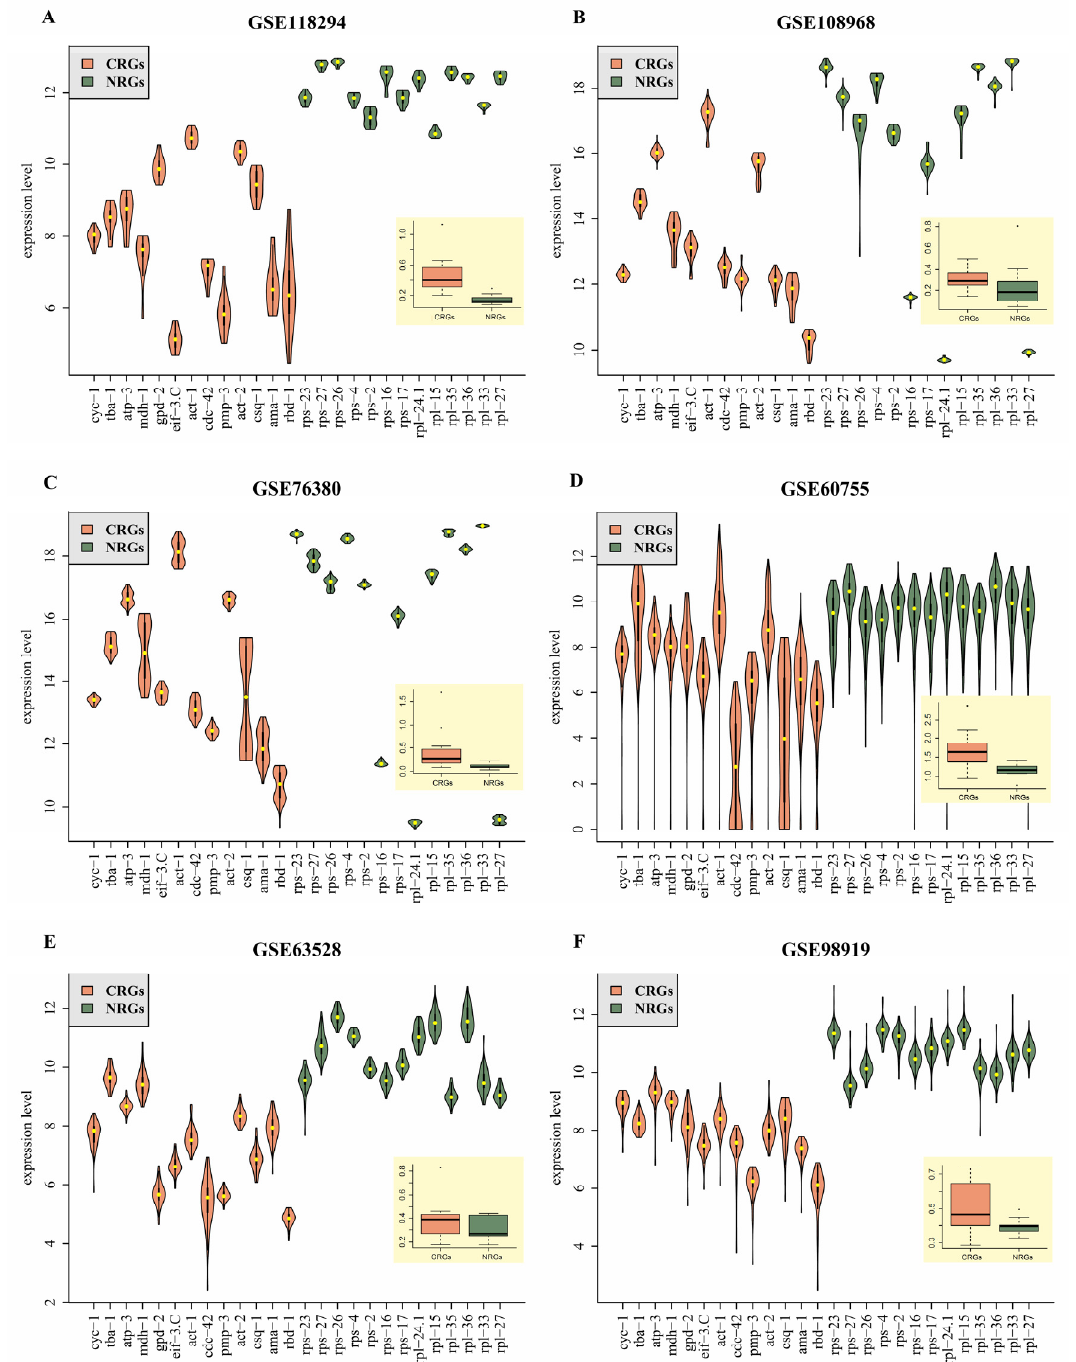
Figure 4. Violin plots showing the reliability of expression levels and boxplots representing standard variations in six independent datasets, for 13 NRGs (dark green) and 13 CRGs (orange). ( A – C ) and ( D – F ) represent validated results by using three microarray datasets and three RNA-seq datasets, respectively.